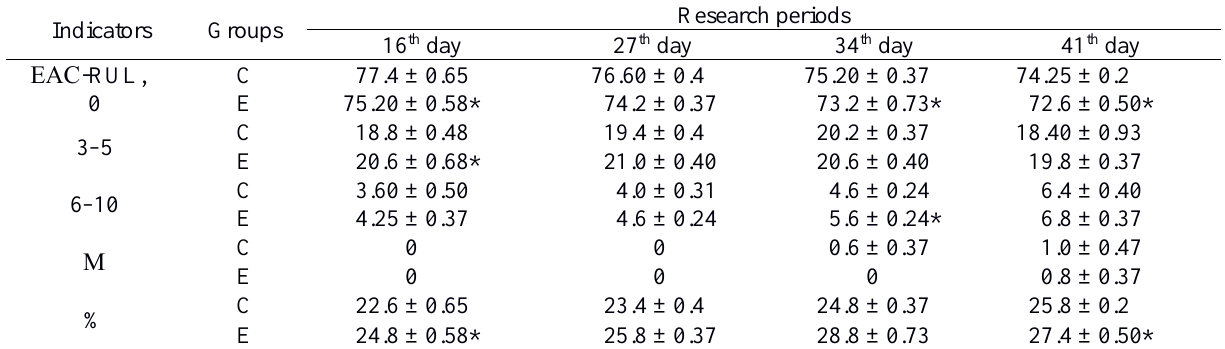
The number of B-lymphocytes and their functional activity in the blood of broiler chickens, % (M ± m; n = 5) Indicators